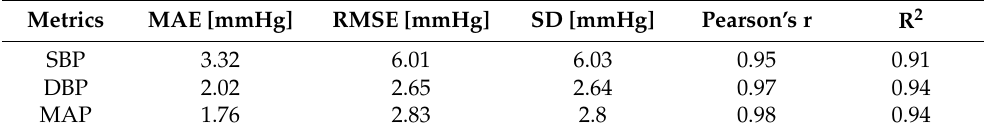
Table 9. Evaluation metrics (public